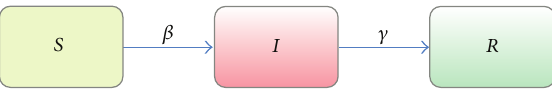
Figure 1: State transition of KM.